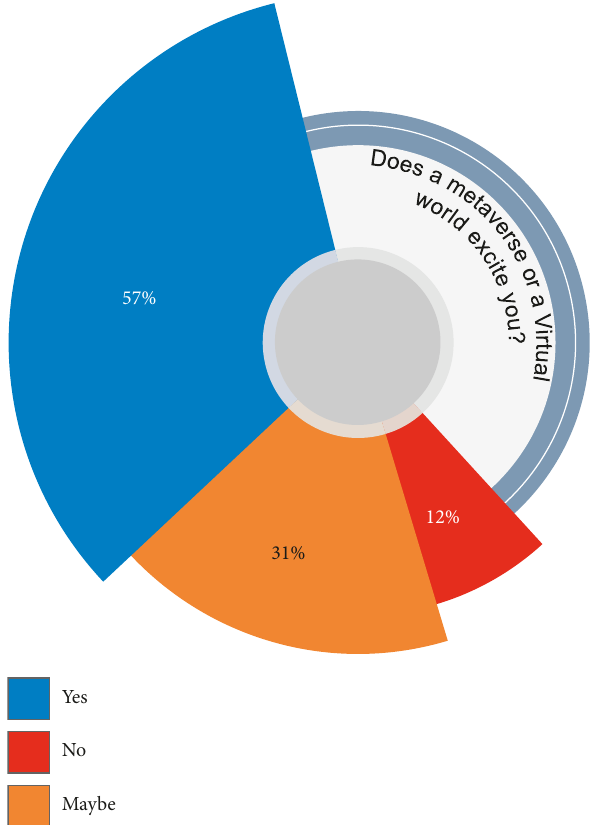
Figure 10: Summarization of the responses when people were asked if they were excited about the metaverse